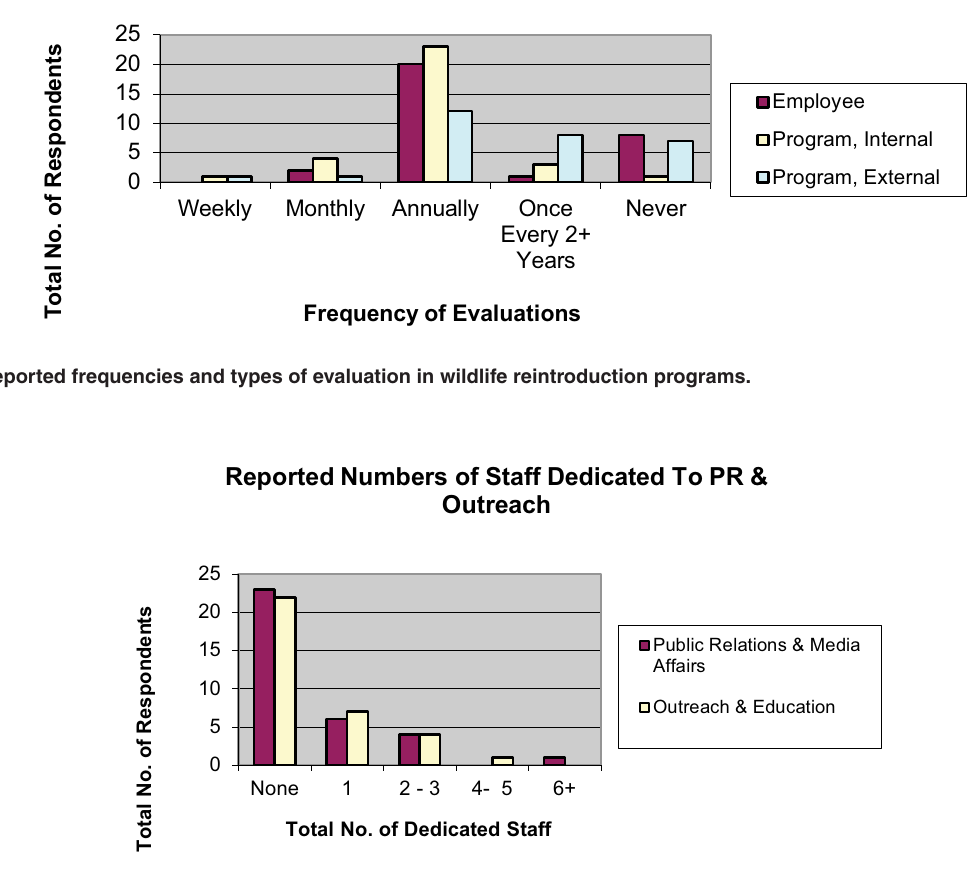
Figure 11. Reported numbers of staff dedicated to public relations and media affairs or public outreach and